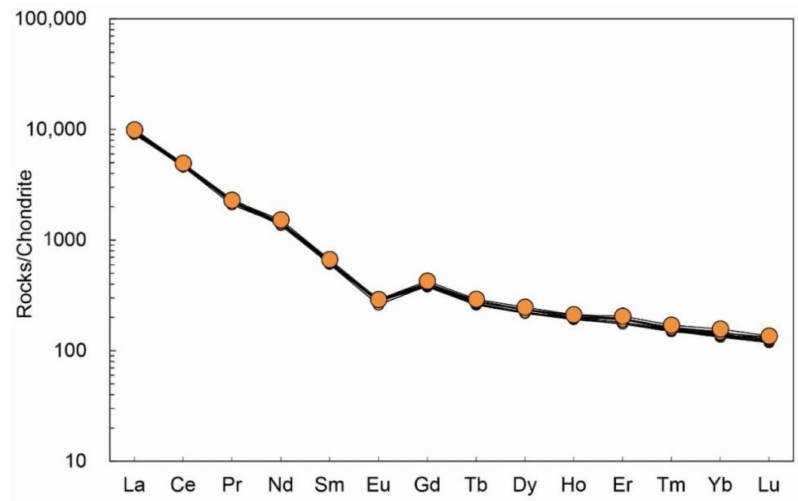
Figure 6. Chondrite-normalised REE distribution patterns of Moroccan apatites. The normalisation values for chondrite were from McDonough and Sun (1989)